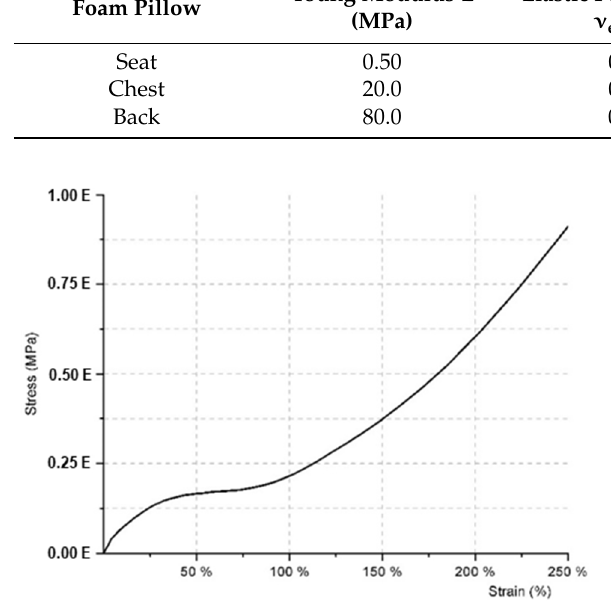
Figure 4. Pillows characteristic curve.